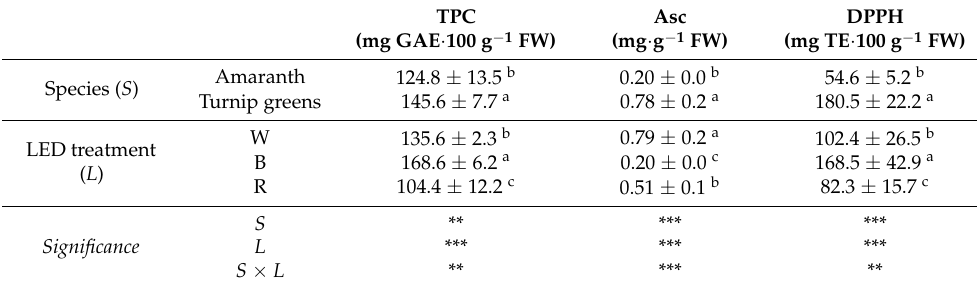
Values (mean ± se ) within each column, followed by the same letter, do not significantly differ at p ≤ 0.05 according to Tukey’s test; significant at p ≤ 0.01 (**) and 0.001 (***). Three biological replicates were used for the analysis ( n =